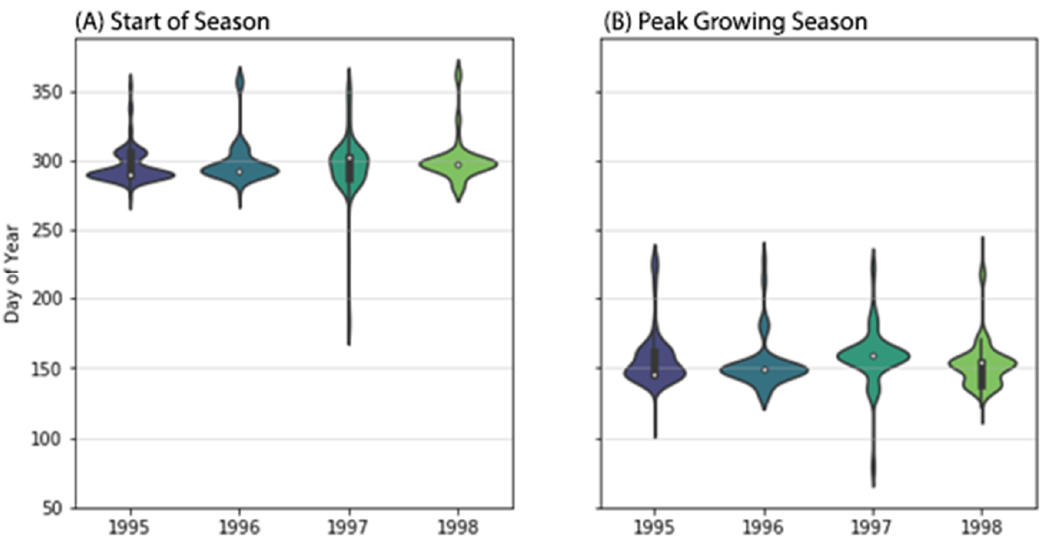
Figure 7. Violin plot of showing the Start of Season ( A ), and Peak of Growing Season ( B ) for mangroves in the Gladstone region (QLD) between 1995–1999, as determined by the apparent phenology. The height of each violin represents the range of values, and the width of each violin represents the number of values in that range.